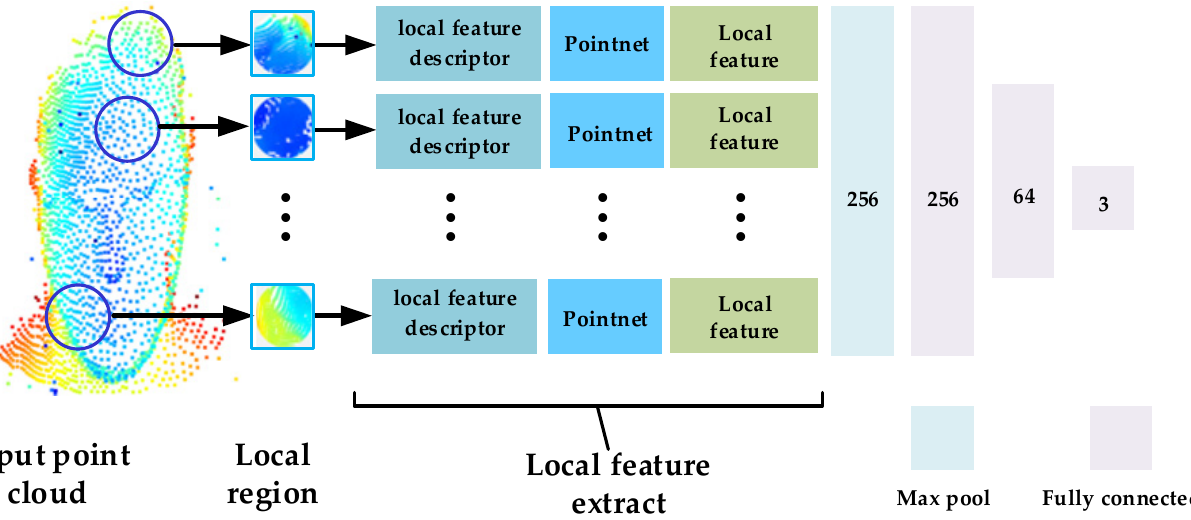
Figure 3. The structure of the head pose prediction network with local feature descriptors. In the figure, 3 fully connected layers are used to map head features to pose angles, where the last layer has 3 filters, which represent 3 pose angles (roll, pitch, and yaw).